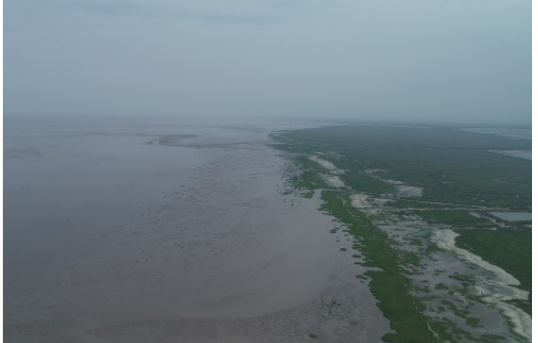
Figure 11. The prograding salt marsh south to the “DLG” river mouth. UAV photo is looking southward and was taken on 29 June 2019.